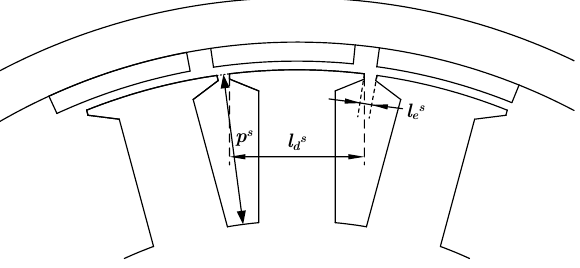
Figure 7. Geometry adopted for the stator slots of the ER-PMSM.